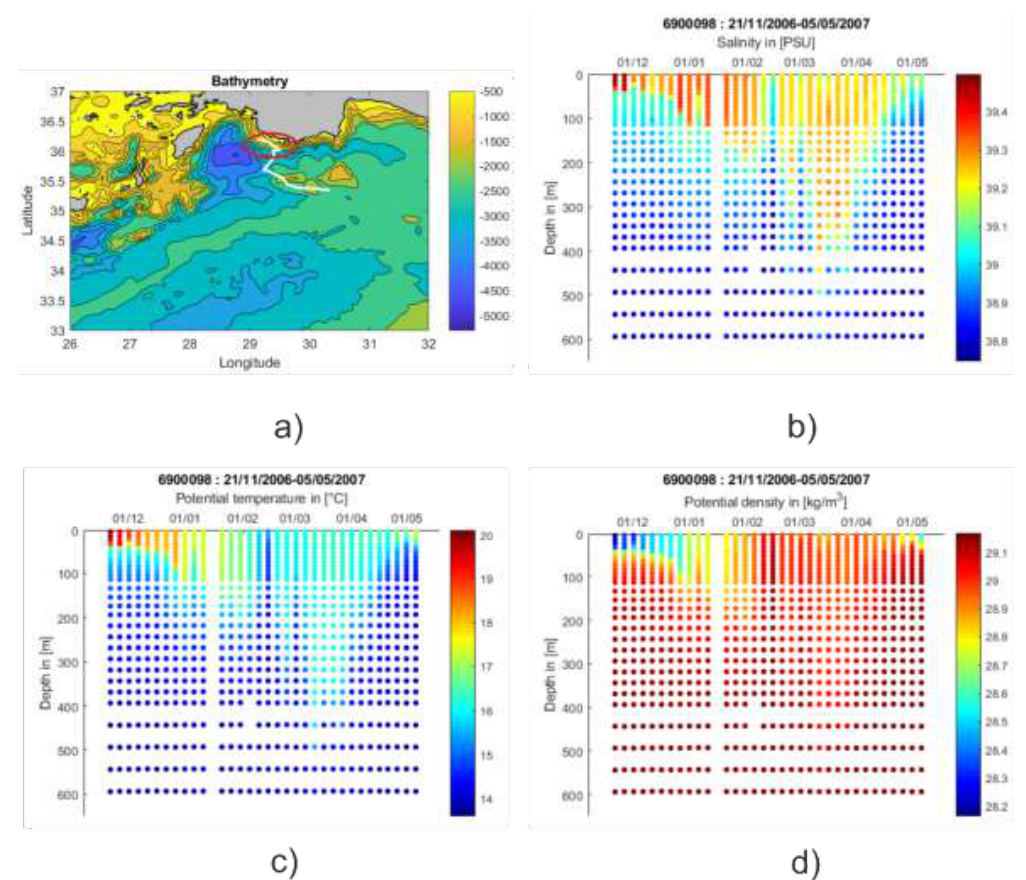
Figure 17. ( a ) Bathymetry of the Northwestern Levantine Sea (m) and float trajectory for float WMO 6900096 during JFM 2007. The red circle indicates the position of the float during March when the deep convection event occurred. Hoevmueller plots of ( b ) salinity (PSU), ( c ) potential temperature (°C), and ( d ) potential density (kgm −3 ).